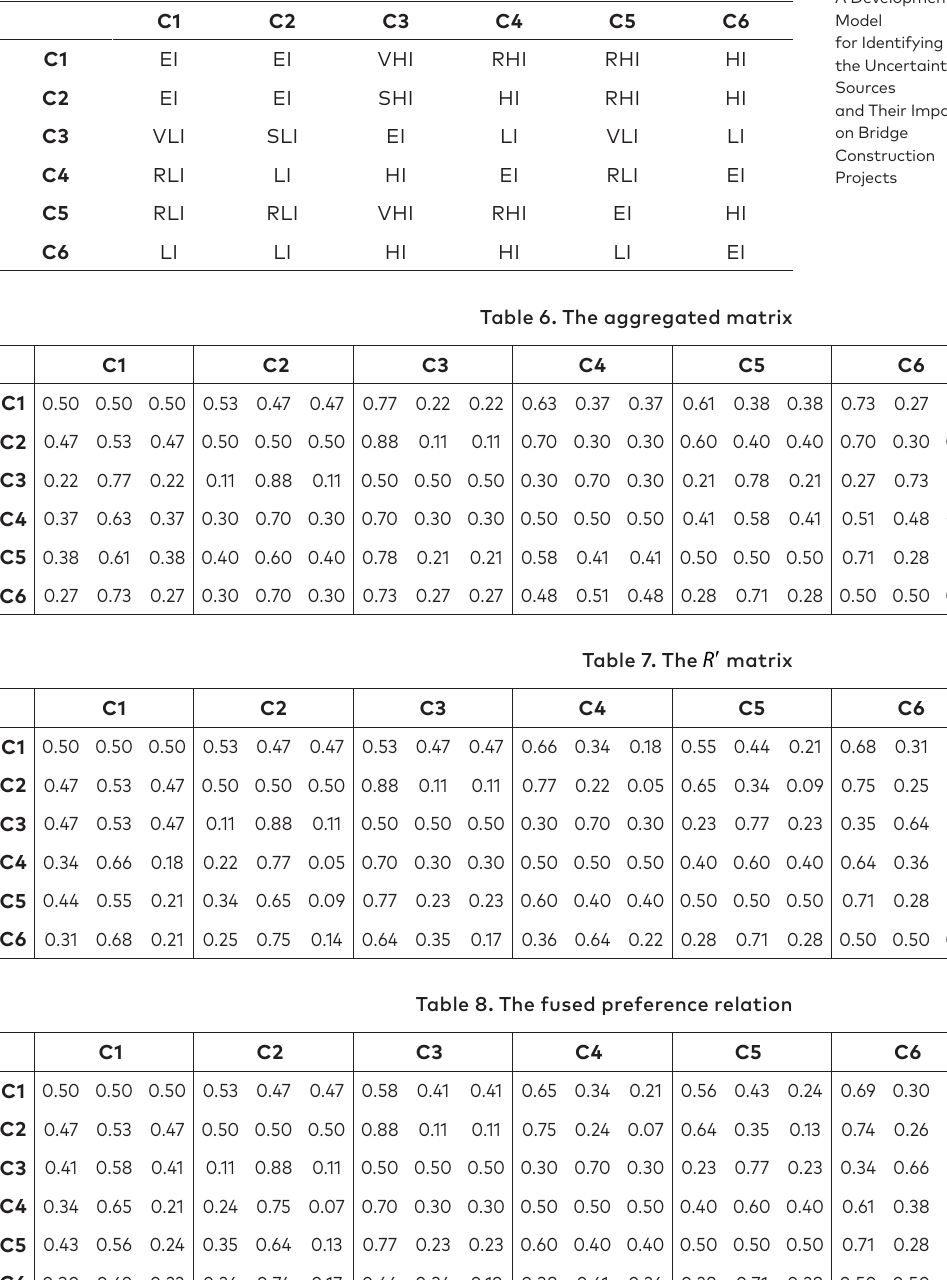
Table 5. A sample of the questionnaire filled by one of the team members